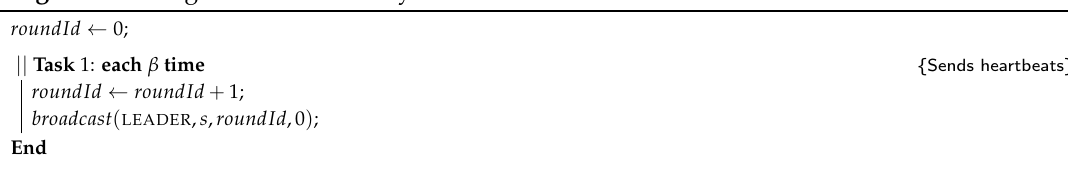
Algorithm 2: Algorithm executed by the sink node s